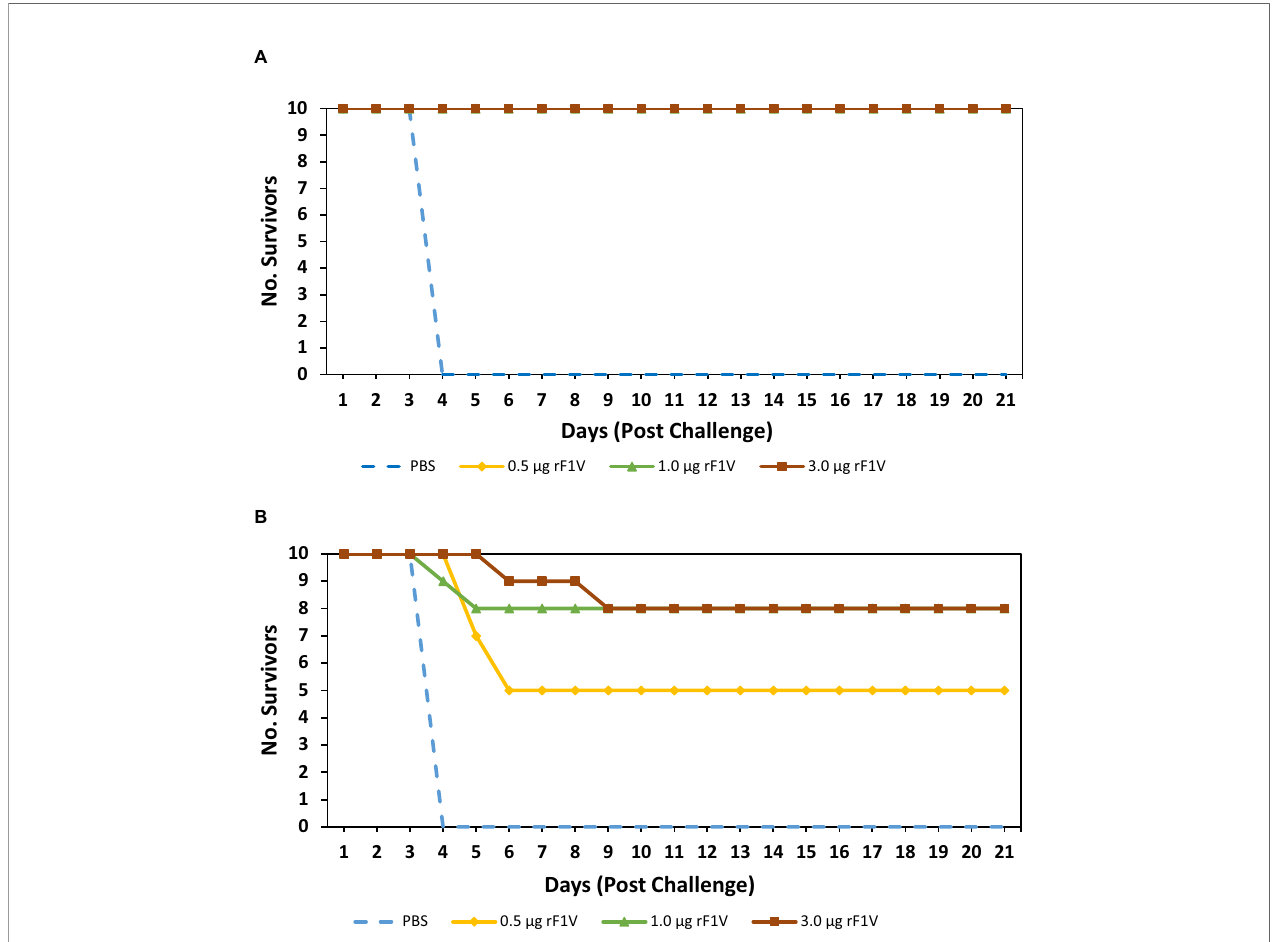
FIGURE 3 | Double dose of rF1V enhances protection against Y. pestis challenge. BALB/c mice were vaccinated with two subcutaneous doses, 3 weeks apart with mock/PBS, 0.5 µg, 1.0 µg or 3.0 µg of rF1V (n=10). At 29 days post vaccination, BALB/c mice were exposed to aerosolized bacteria with (A) 4.53x10 5 CFU (approximately 7 LD 50 equivalents) of Y. pestis CO92 or (B) 6.09x10 5 CFU (approximately 8 LD 50 equivalents) of Y. pestis C12, respectively. Survival was monitored for 21 days post challenge.